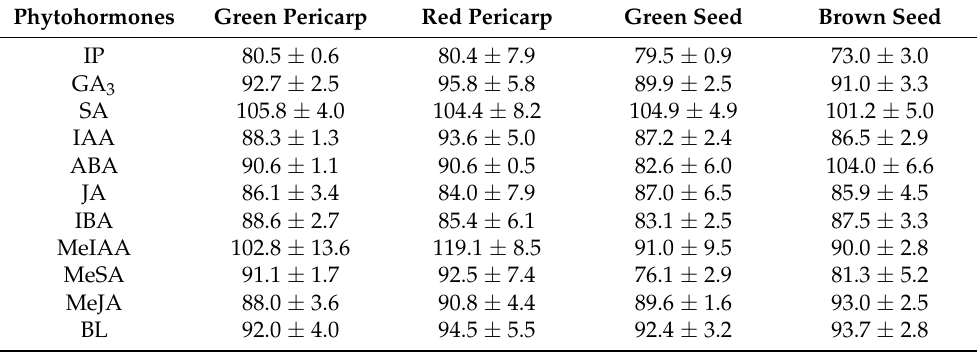
Figure 6. The chromatograms of IP, GA 3 , SA and IAA in different concentration conditions (nitrogen blow with and without 1 mL MeOH). Table 2. Matrix effects of 11 phytohormones in the pericarp and seed of green and red grape berries (%, n =